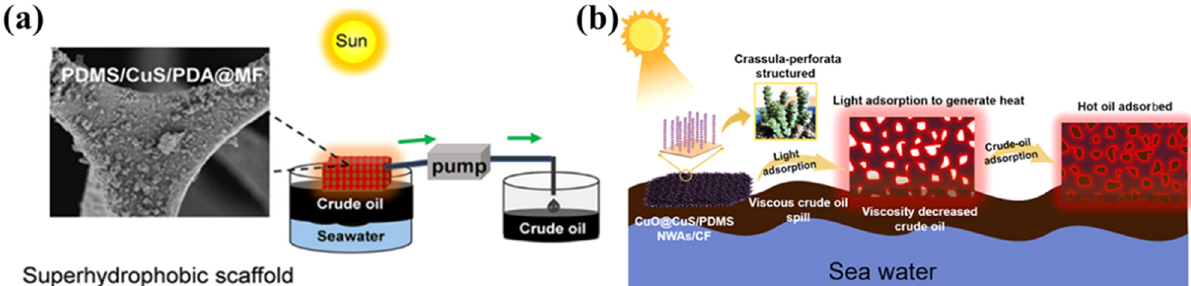
Figure 1: ( a ) Solar - assisted in situ crude oil recovery [ 53 ] . ( b ) CuO@CuS/PDMS NWA growth and crude oil adsorption diagram [ 54 ]